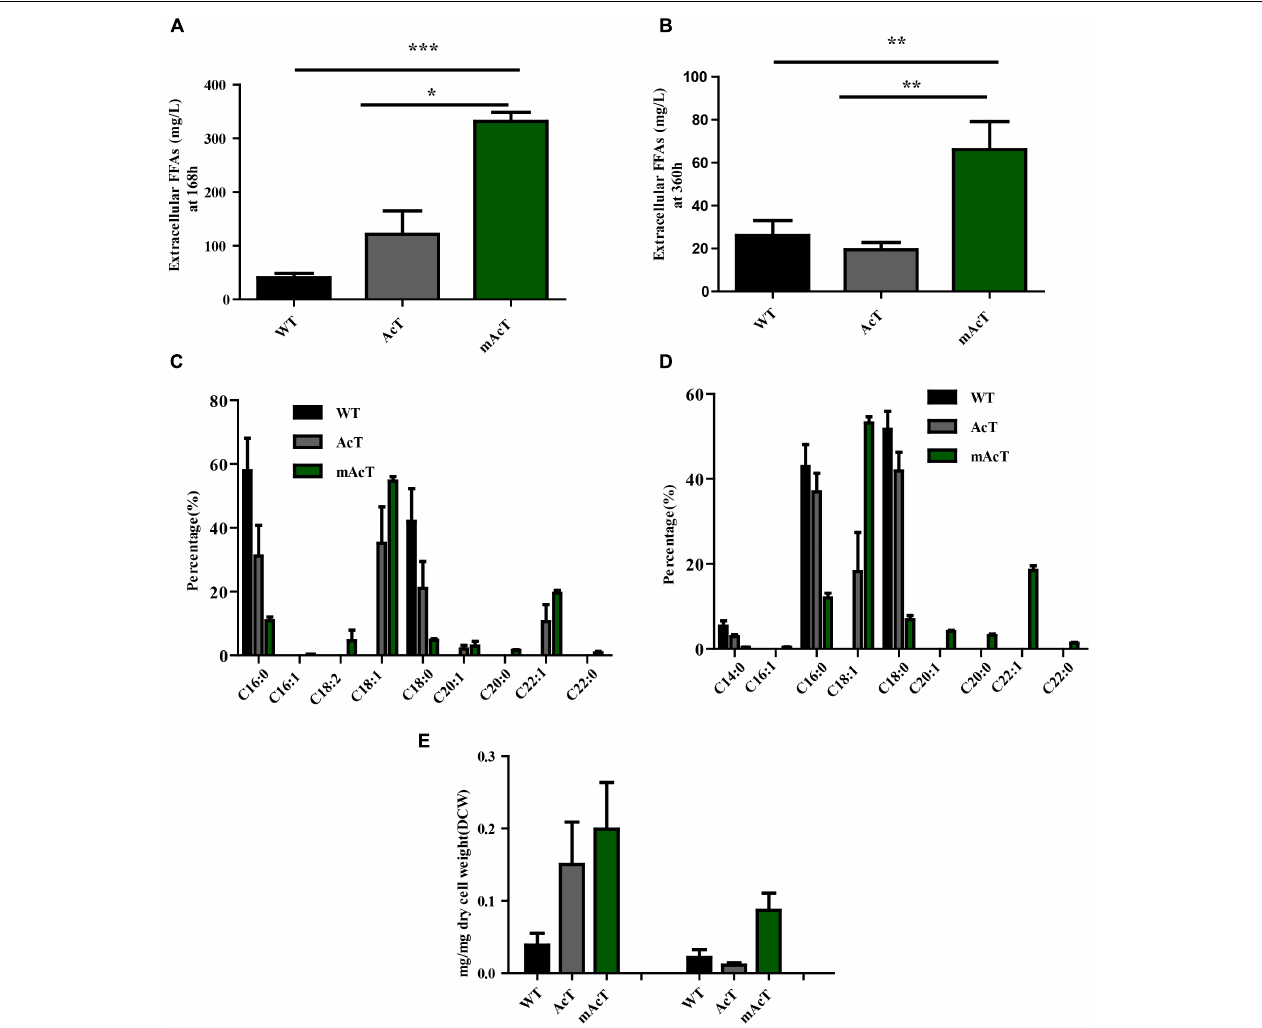
FIGURE 4 | Effects of CO 2 on extracellular FFA production. Cultures were grown at 30 ◦ C in a BG-11 medium under continuous illumination of 50 µ mol photons m − 2 s − 1 light and bubbled with 1% CO 2 -enriched air. Measurement of (A) extracellular FFAs at 168 h and (B) extracellular FFAs at 360 h. Profiles of (C) extracellular FFAs at 168 h and (D) extracellular FFAs at 360 h of WT, AcT and mAcT. (E) Extracellular FFA amount after normalization with dry cell weight (DCW) at two time points, 168 and 360 h. Data shown in (A–E) are the mean ± SE from biological triplicates, and ‘ ∗ ’ represents statistical significance as indicated by Student’s t -test with a maximum p -value of <